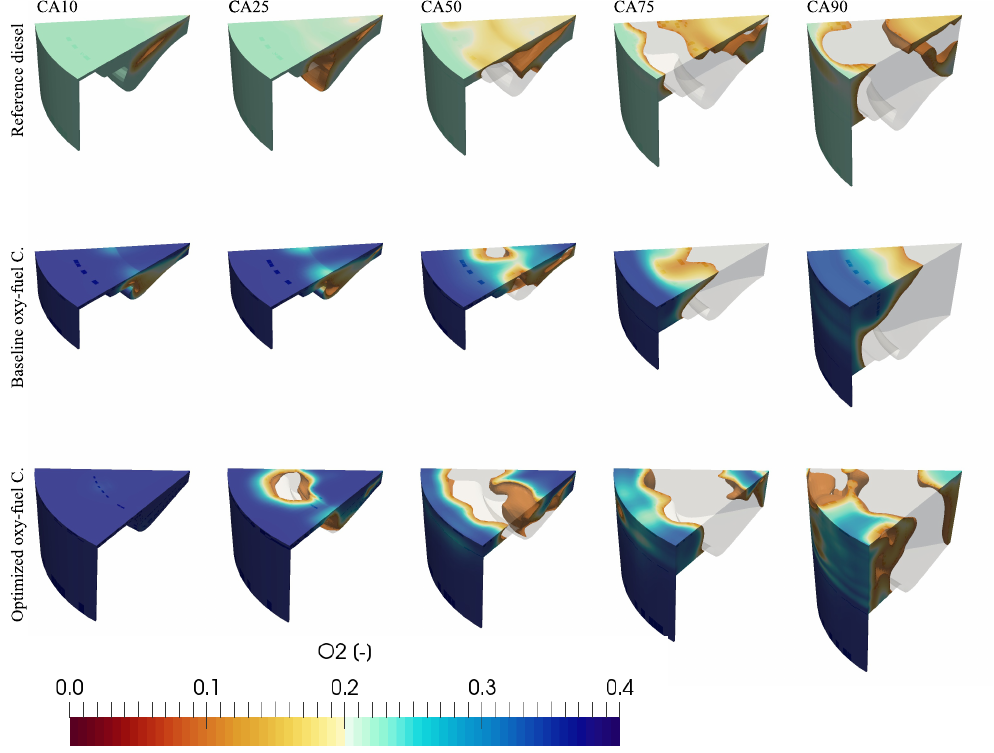
Figure 16. O 2 distribution inside the combustion chamber for several combustion periods (CA) and comparison between the reference diesel, baseline, and optimized oxy-fuel combustion